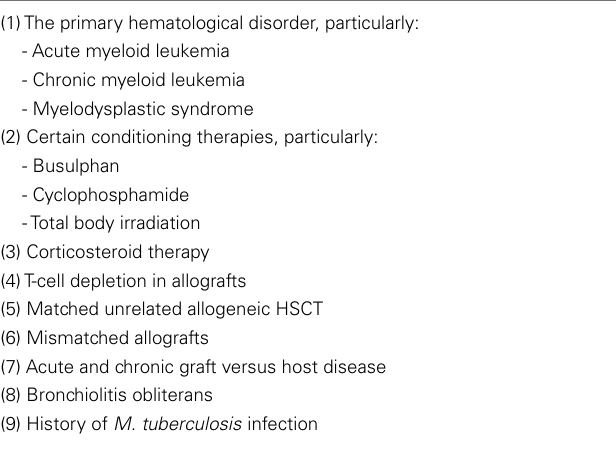
Table 3 | Risk factors for M. tuberculosis infections in recipients of HSCT